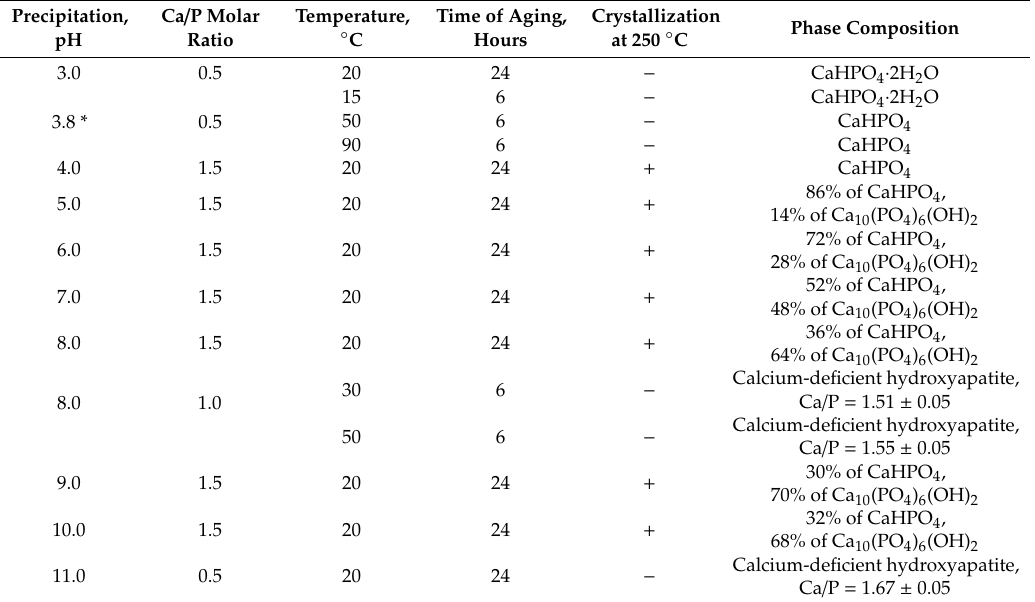
Table 2. The conditions of synthesis and aging, phase composition of calcium phosphate precipitates. Precipitation,